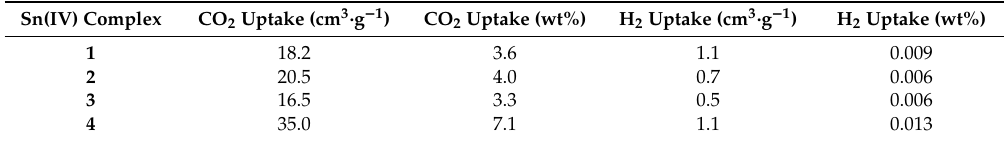
Table 6. Gas uptake capacities at 323 K and 50 bars of complexes 1 – 4 .